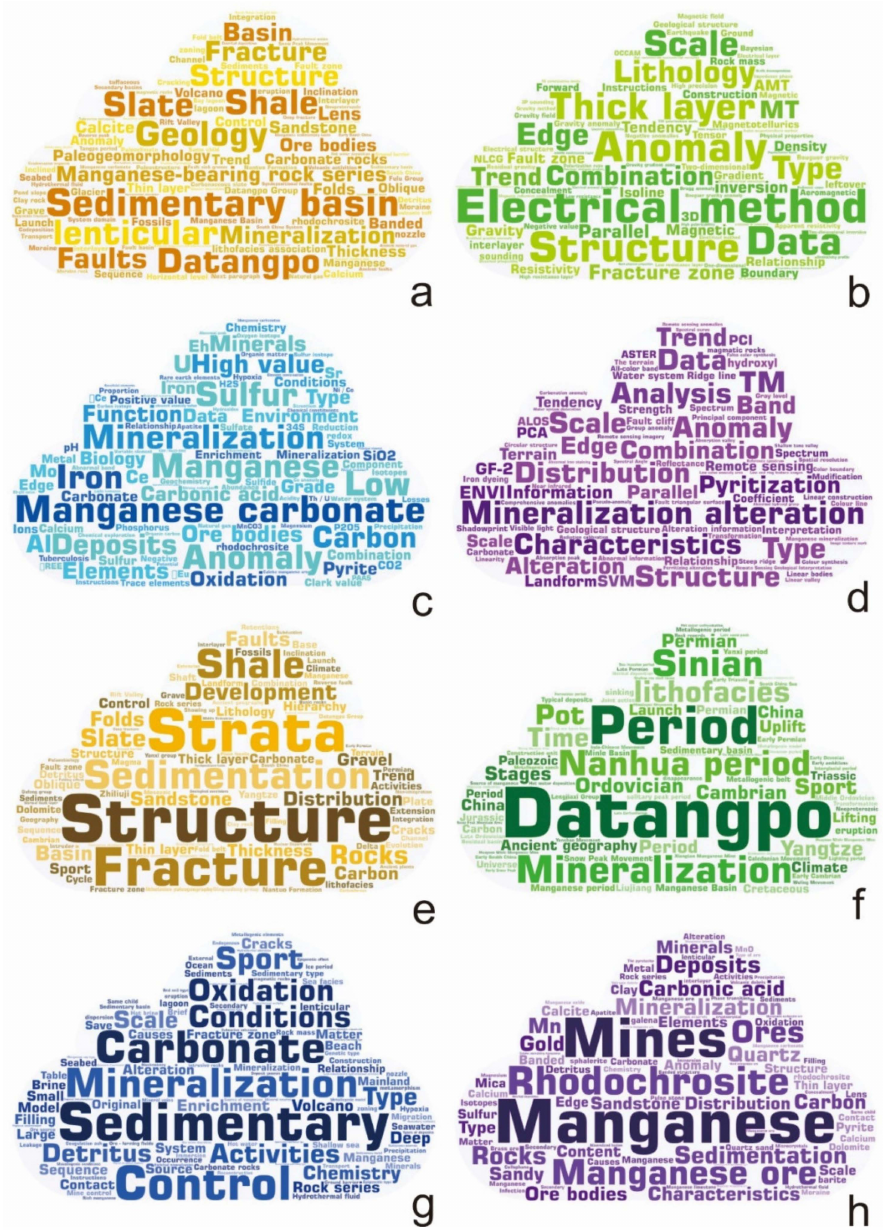
Figure 7. Word clouds of Songtao-Huayuan manganese ore: ( a ) geological prospecting, ( b ) geo- physical prospecting, ( c ) geochemical prospecting, ( d ) remote sensing, ( e ) metallogenic background, ( f ) metallogenic period, ( g ) genetic type, and ( h ) mineralization